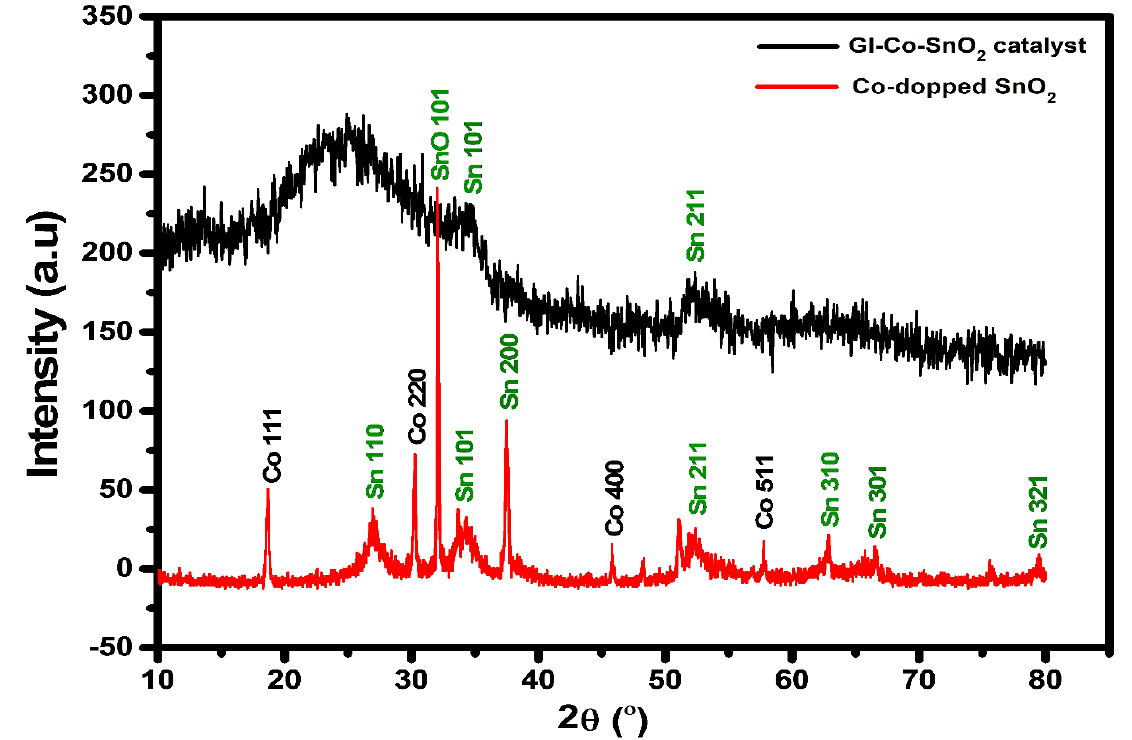
Figure 3. XRD patterns of Co − SnO 2 nanomaterial (dark line) and GL/Co − SnO 2 hydrogel nanocom- posite material (red line).